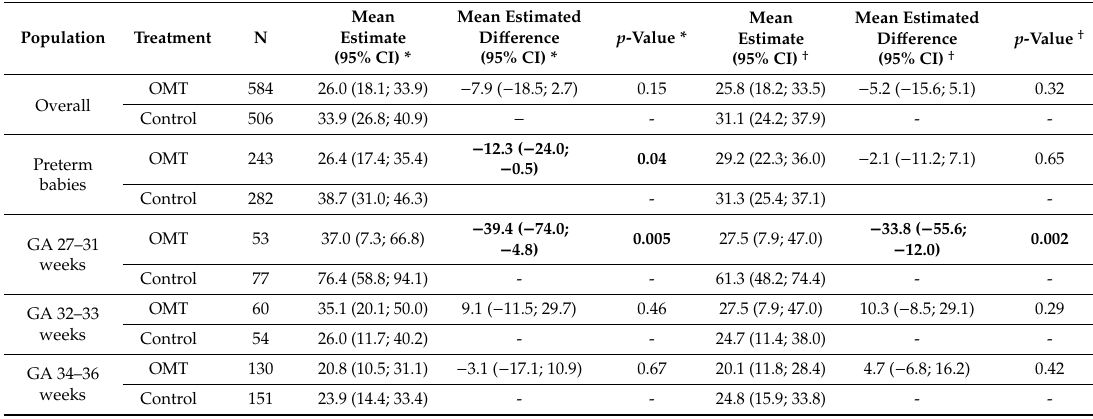
Table 2. Impact of OMT vs. usual care on LOS. Results of linear regression models.